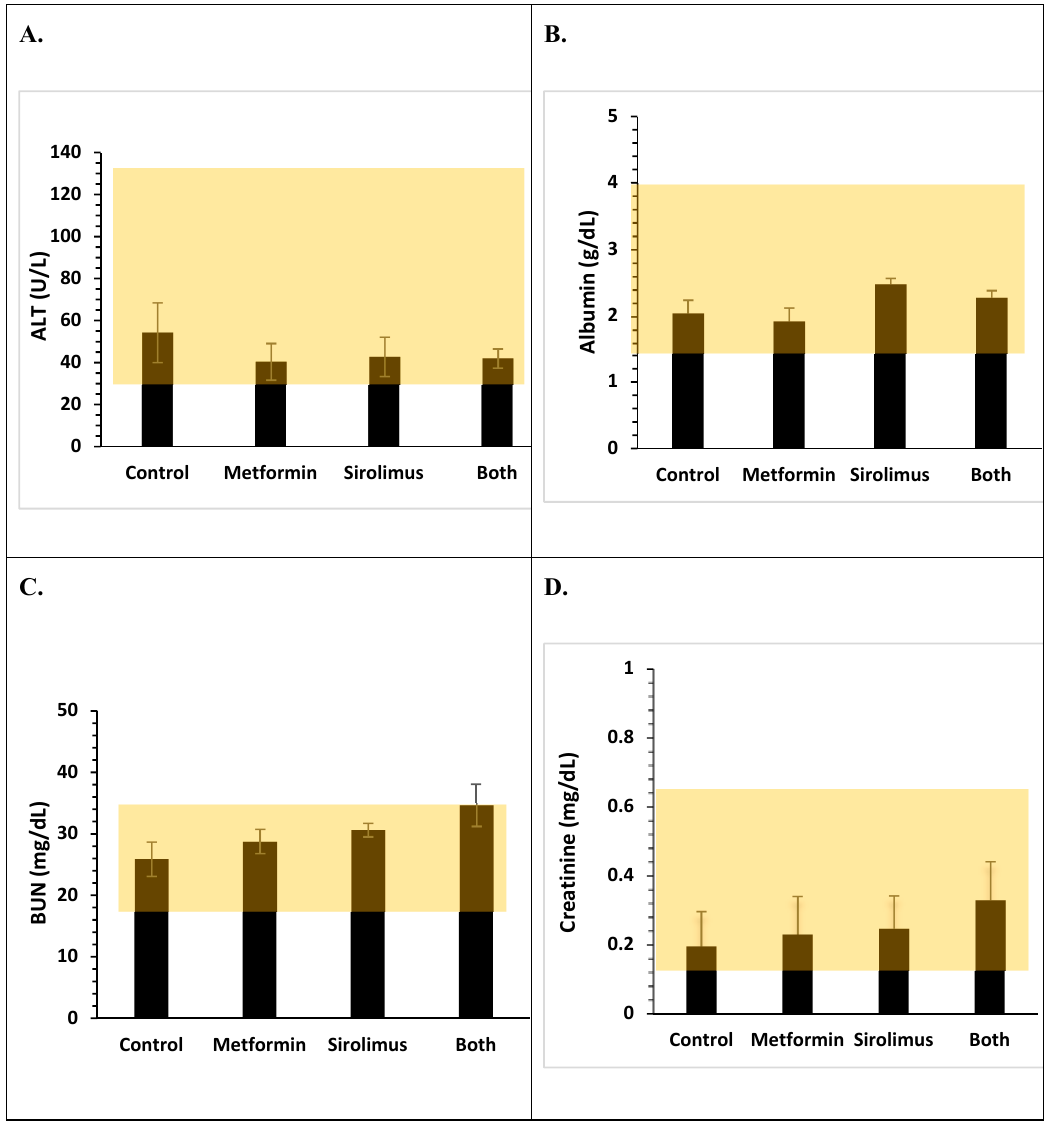
Figure 6. Clinical chemistry parameters of Balb/C mice after one month of treatment with water or MET alone or SRL alone or MET + SRL therapy following which blood was collected and analysed for the indicated parameters. ( A ) Serum alanine aminotransferase, ALT(U/L)) levels. ( B ) Serum Albumin (g/dL) levels. ( C ) Serum blood urea nitrogen, BUN (mg/dL). ( D ) Serum creatinine (mg/dL) levels. The shaded box in each graph represents the normal range for that particular parameter. The results are representative of two independent experiments.